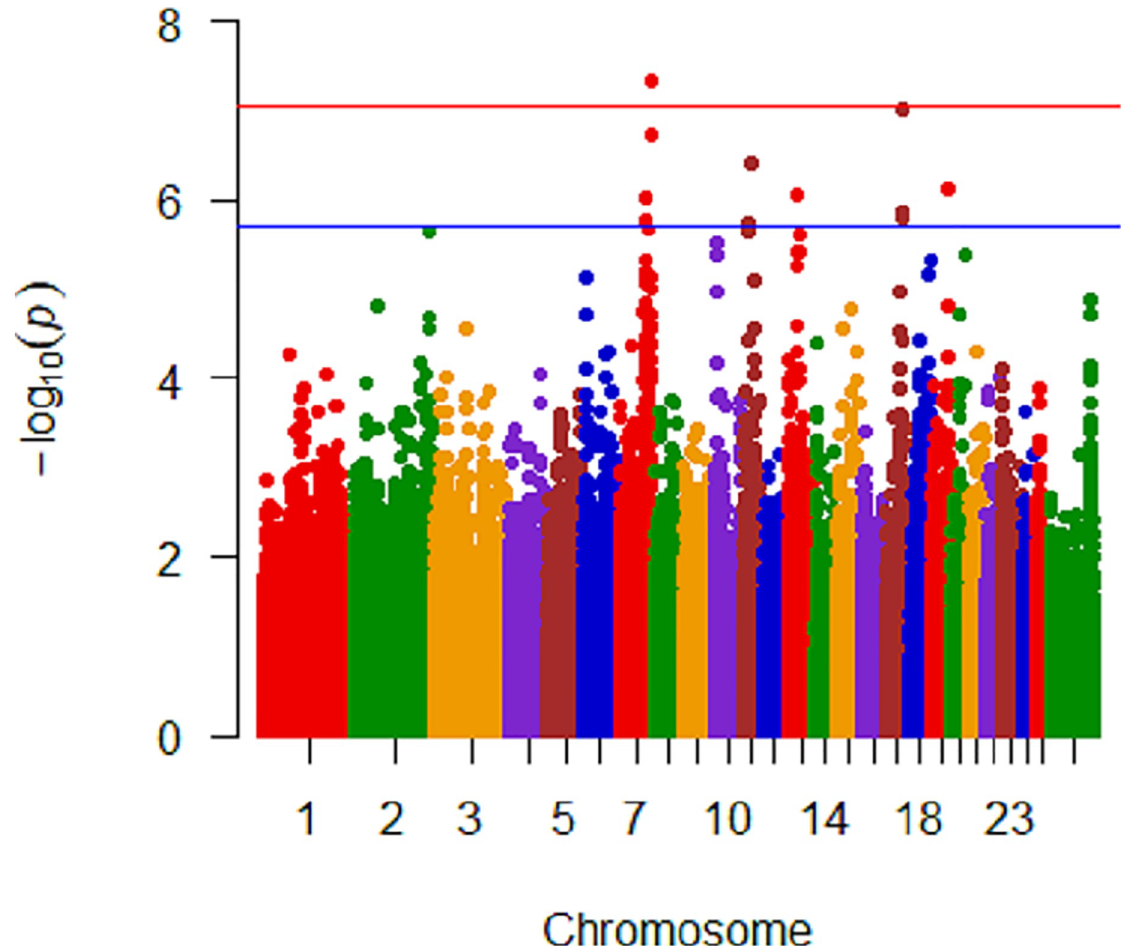
Fig 5. Manhattan plot of Polypay analysis with untransformed M . ovipneumoniae mean DNA copy number. Significant SNPs are on chromosomes 7 and 17. Genome significant line is red and genome suggestive line is blue.